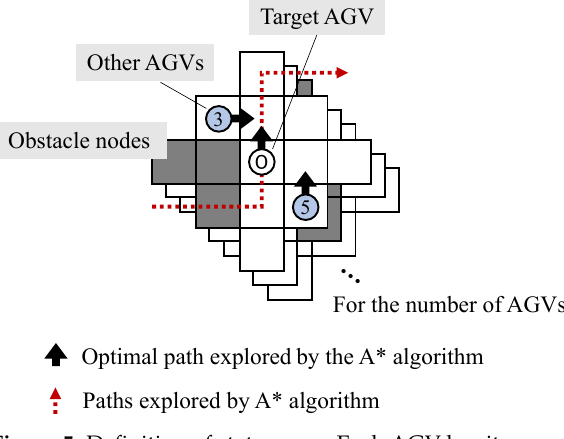
Figure 5. Definition of state space. Each AGV has its own state space centered on its position.